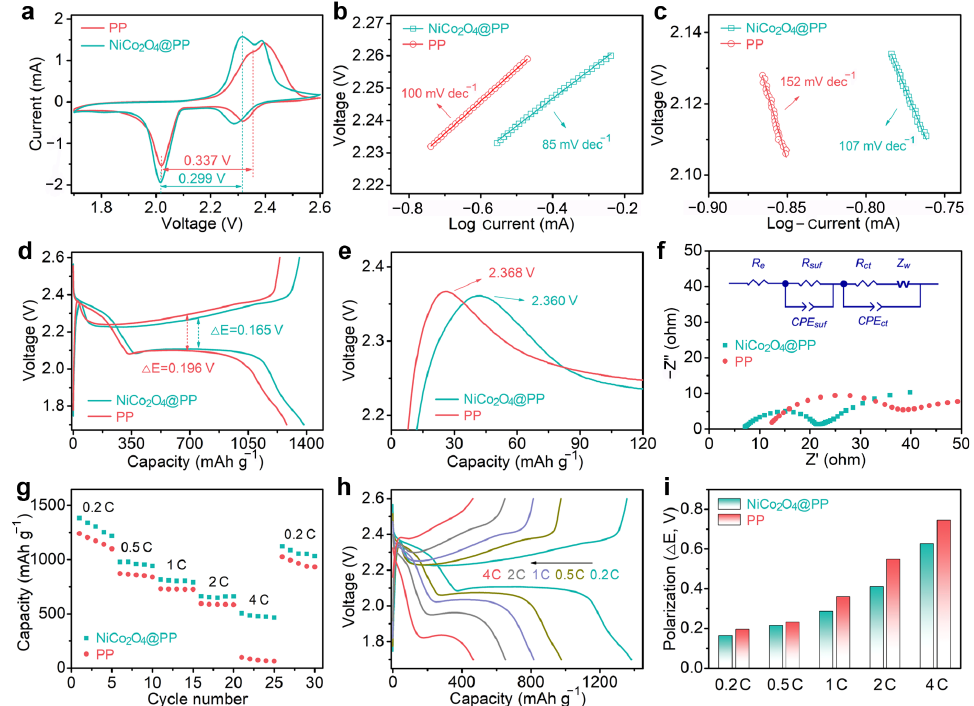
Figure 4. ( a ) The CV curves with pure PP and modified separators at 0.1 mV s − 1 . ( b , c ) Corresponding Tafel results and fitted slope values. ( d , e ) Comparison of the charge–discharge plots at 0.2 C, and the corresponding initial process of the charge details. ( f ) EIS spectra. The inset is the corresponding equivalent circuit. R e is the electrolyte resistance. R suf is the surface resistance. R ct is the charge transfer resistance. Z w is the Warburg impedance. The constant phase element (CPE) was used to compensate for the non-ideal behavior of the electrode. ( g , h ) Rate performance and charge–discharge curves at different currents. ( i ) Comparison of the potential polarizations of different separators. Figure 4d reveals the charge–discharge plots of different separator systems at 0.2 C.